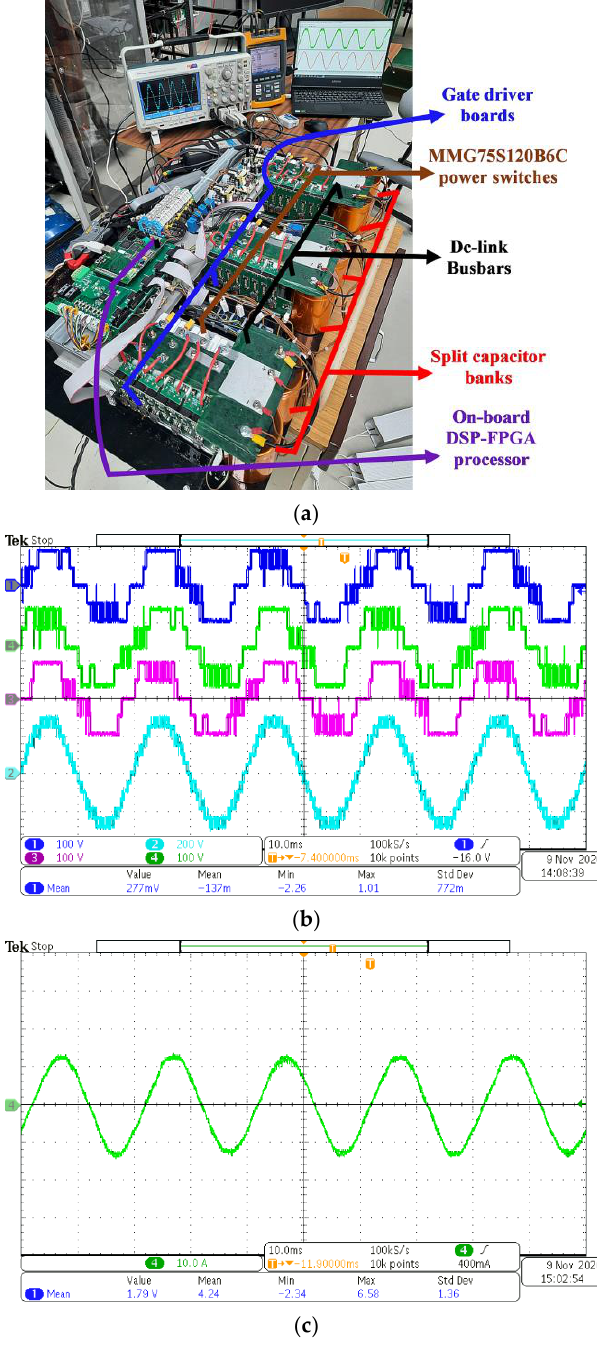
Figure 10. Experimental results from the laboratory prototype setup of the three cascaded 5-level MLI. ( a ) Laboratory prototype setup, ( b ) Individual cell 5-level output voltages and the overall 13-level inverter output voltage waveform, ( c ) Load current waveform. Experimental input and output powers of the inverter prototype were measured with Fluke-434-435 power-quality-analyzer and power analysis application module MDO3PWR in MDO3034 oscilloscope. Figure 11 shows the measured capacitor bank voltages and the overall inverter output voltage; output and input powers of the inverter. It is apparent